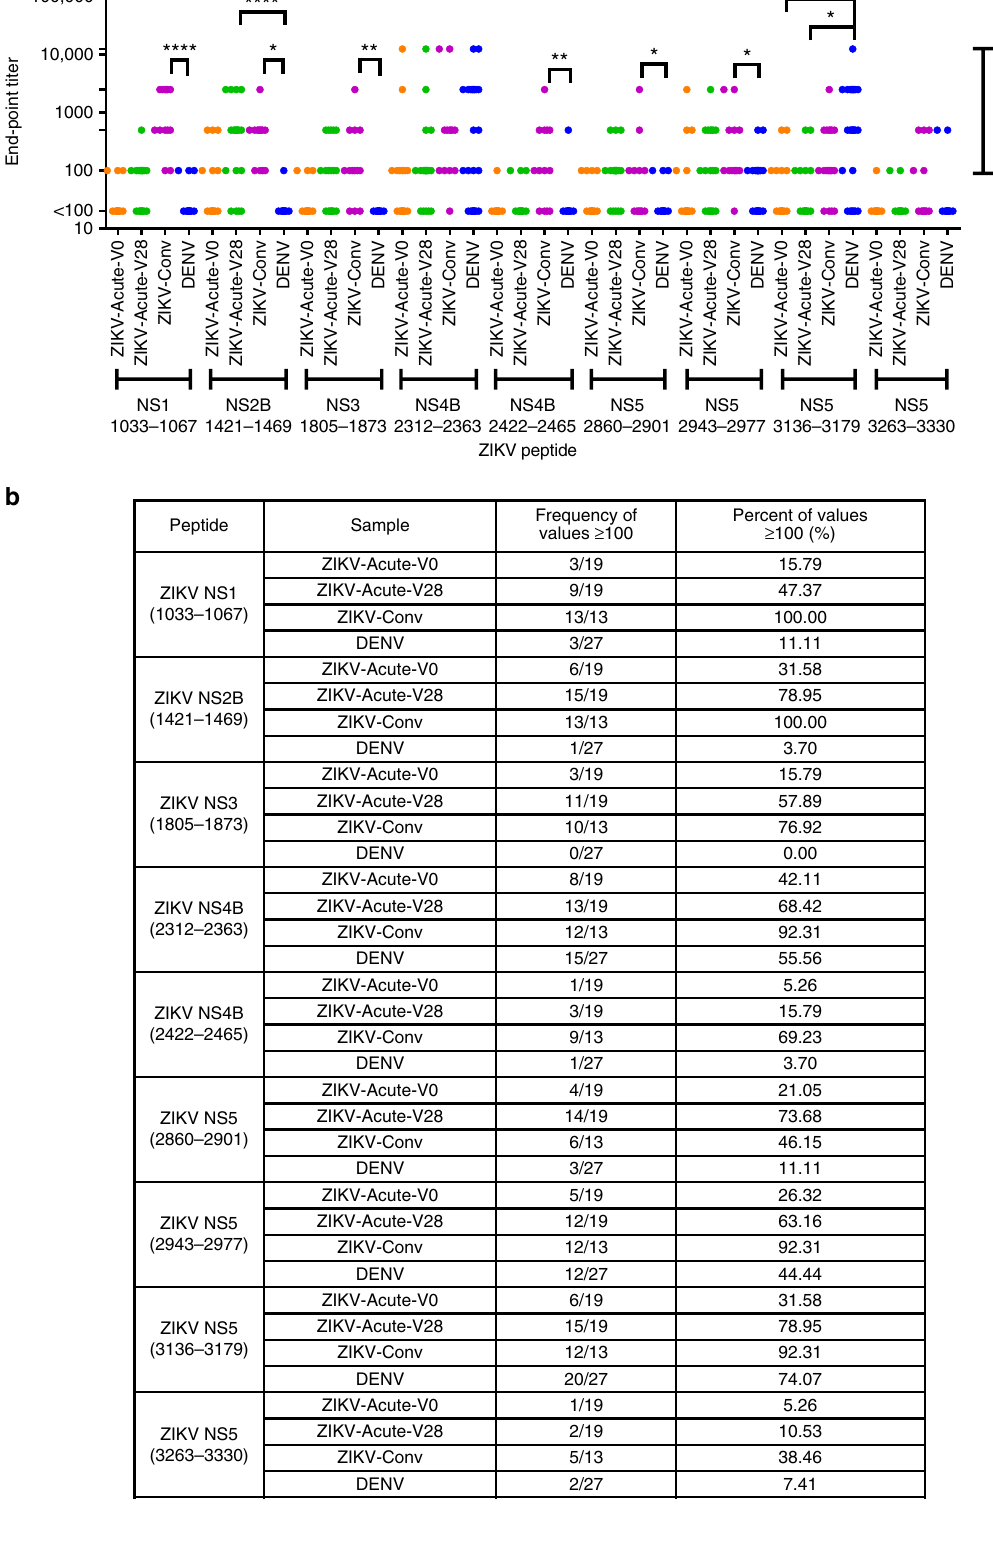
The ZIKV-NS5-3263-3330 peptide showed weak reactivity to few (7 – 38%) convalescent ZIKV and DENV-infected samples. The peptides ZIKV-NS4B-2312-2363 (overlapping Z-23.1), ZIKV-NS5-2943-2977 (within Z-30) and ZIKV-NS5-3136-3179 (overlapping Z-32.2) all showed weak/moderate